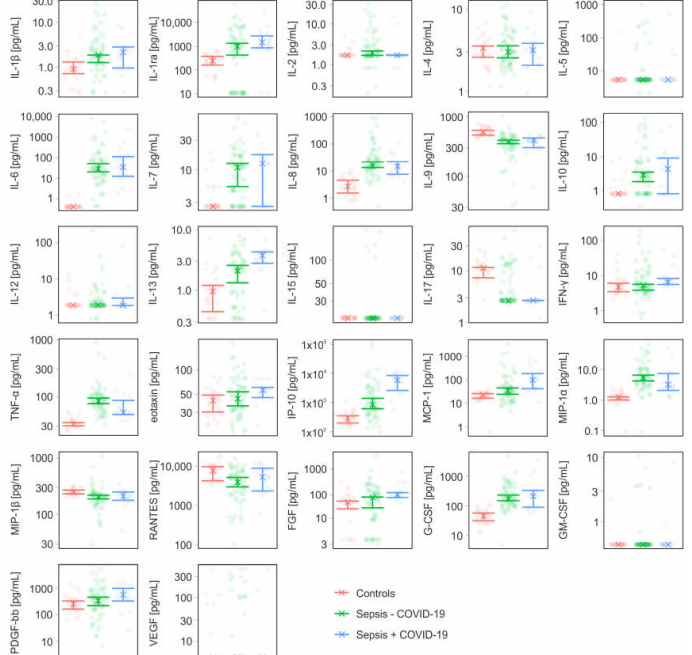
Figure 2. Profiles of cytokines, chemokines, and growth factors in sepsis patients without (Sepsis − COVID-19) and with COVID-19 (Sepsis + COVID-19), and healthy controls. The x represents the median of the